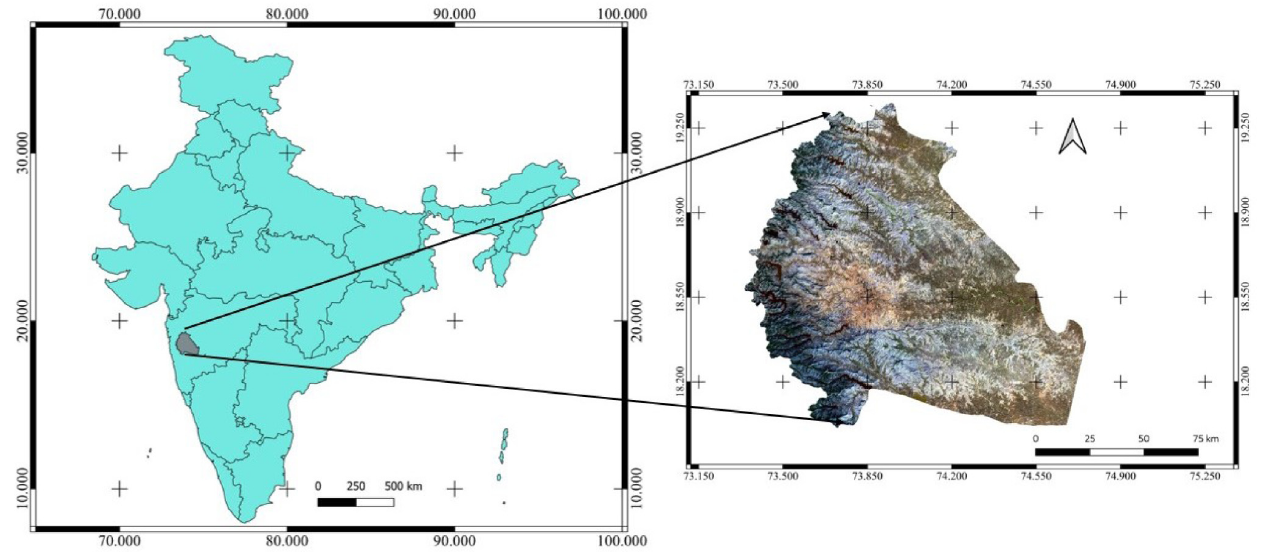
Figure 1. Study area location and extent. Landsat 8 image courtesy of the U.S. Geological